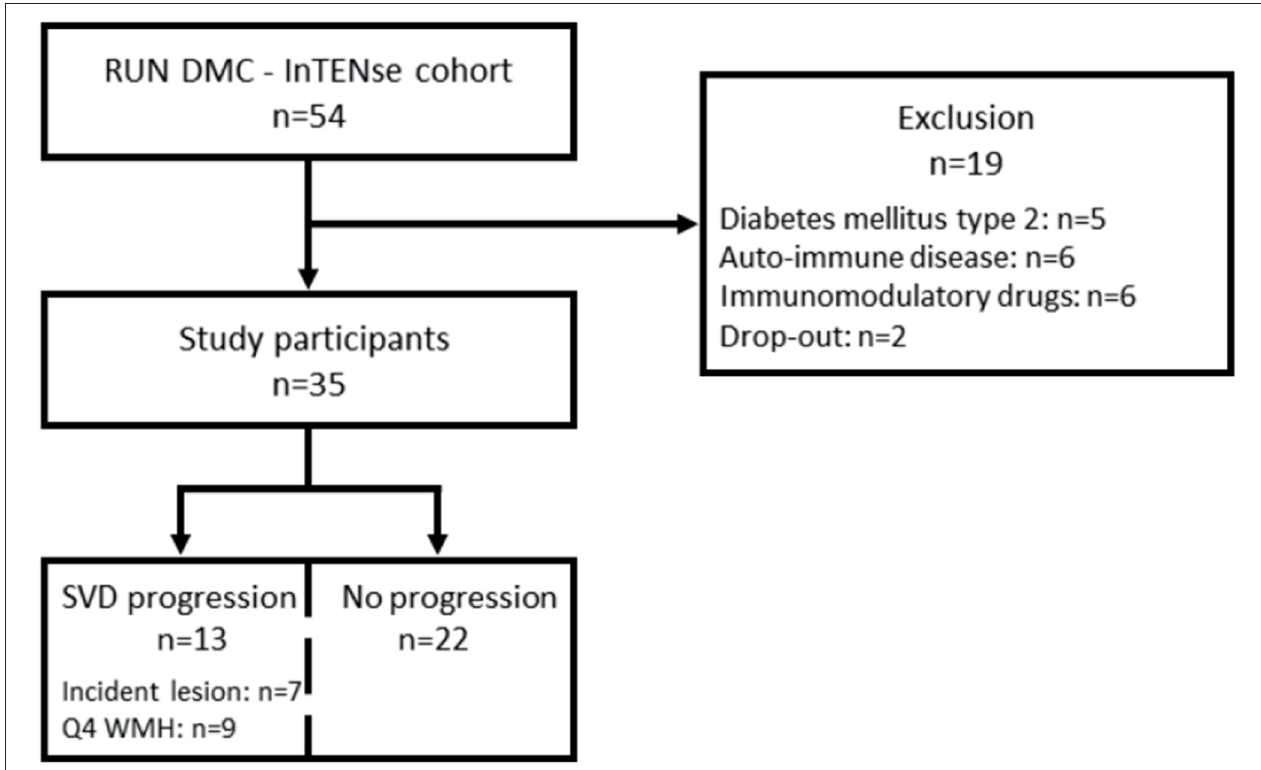
FIGURE 1 | Flow diagram of included participants of the RUN DMC–InTENse cohort. Drop-out indicates premature stop before blood sampling. DM2, diabetes mellitus type 2; AID, autoimmune disease; drug use, chronic immunomodulatory drug use; 4Q WMH, highest quartile of WMH; WMH, white matter hyperintensity. blood and subsets were comparable in participants with SVD progression to those without progression ( Table 2